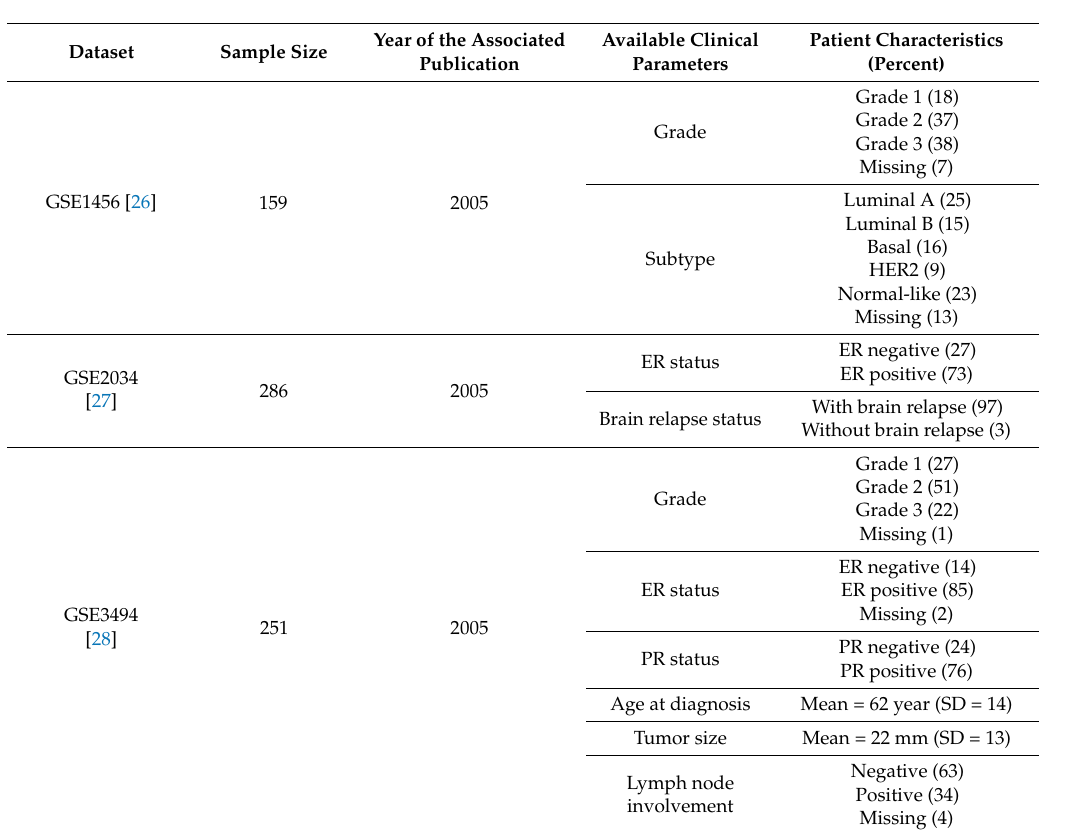
Figure 1. The association between MCM10 expressions, tumor grade and estrogen receptor status. Box plots showing the mean, 95% confidence interval and range of MCM10 mRNA expression in breast cancer datasets in tumors with different histologic grade in ( A ) GSE1456 ( n = 147); ( B ) GSE3494 ( n = 234); ( C ) GSE 7390 ( n = 196) and ( D ) GSE11121 ( n = 200); the association between MCM10 expressions and estrogen receptor status. Box plots showing the mean, 95% confidence interval and range of MCM10 mRNA expression in breast cancer datasets in tumors with different estrogen receptor status in ( E ) GSE2034 ( n = 286); ( F ) GSE3494 ( n = 232) and ( G ) GSE7390 ( n = 198). Table 1. Clinicopathological details of six different data sets used in the paper.